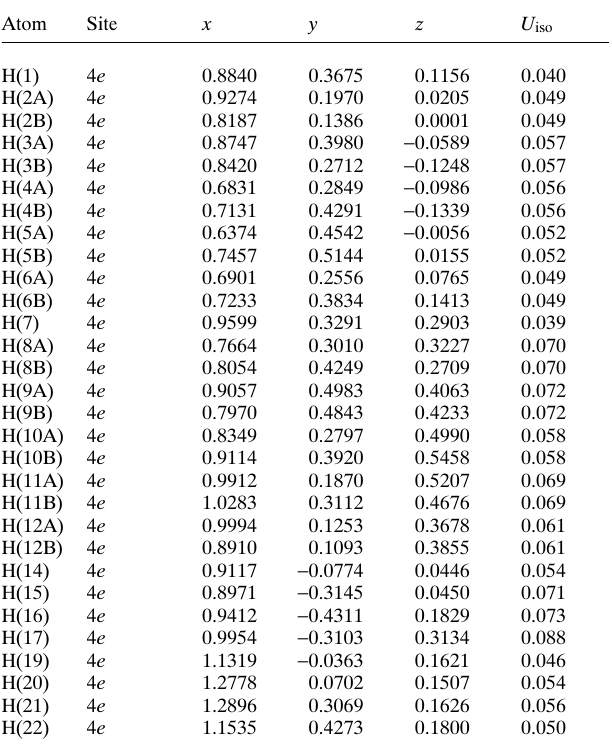
Table 2. Atomic coordinates and displacement parameters (in Å 2 )